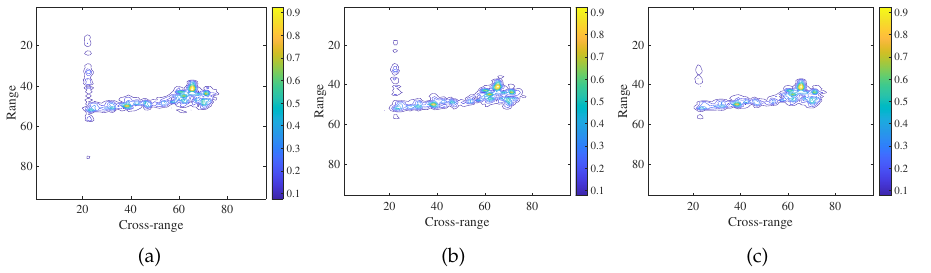
Figure 13. The imaging results of 50% measurements of ship data yield by GDL method in the three cases of ( a ) λ = 0.02, ( b ) λ = 0.035, and ( c ) λ =